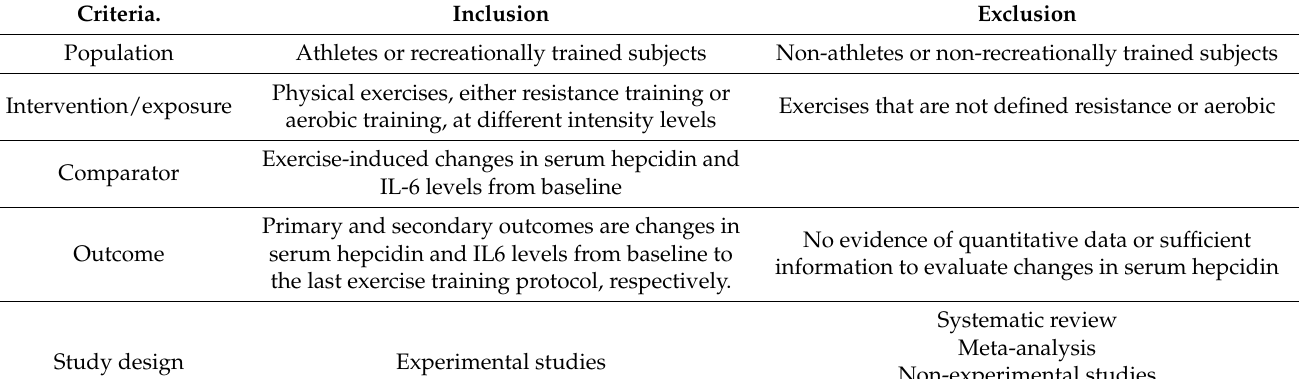
Table 1. PICOS criteria for inclusion and exclusion of